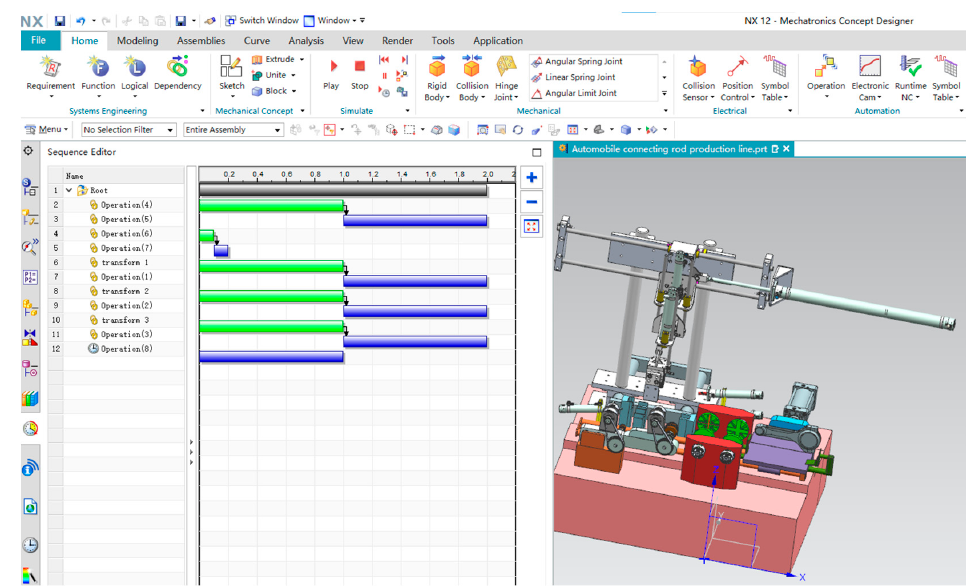
Figure 8. Simulation sequence of the model of the first part of the processing area.